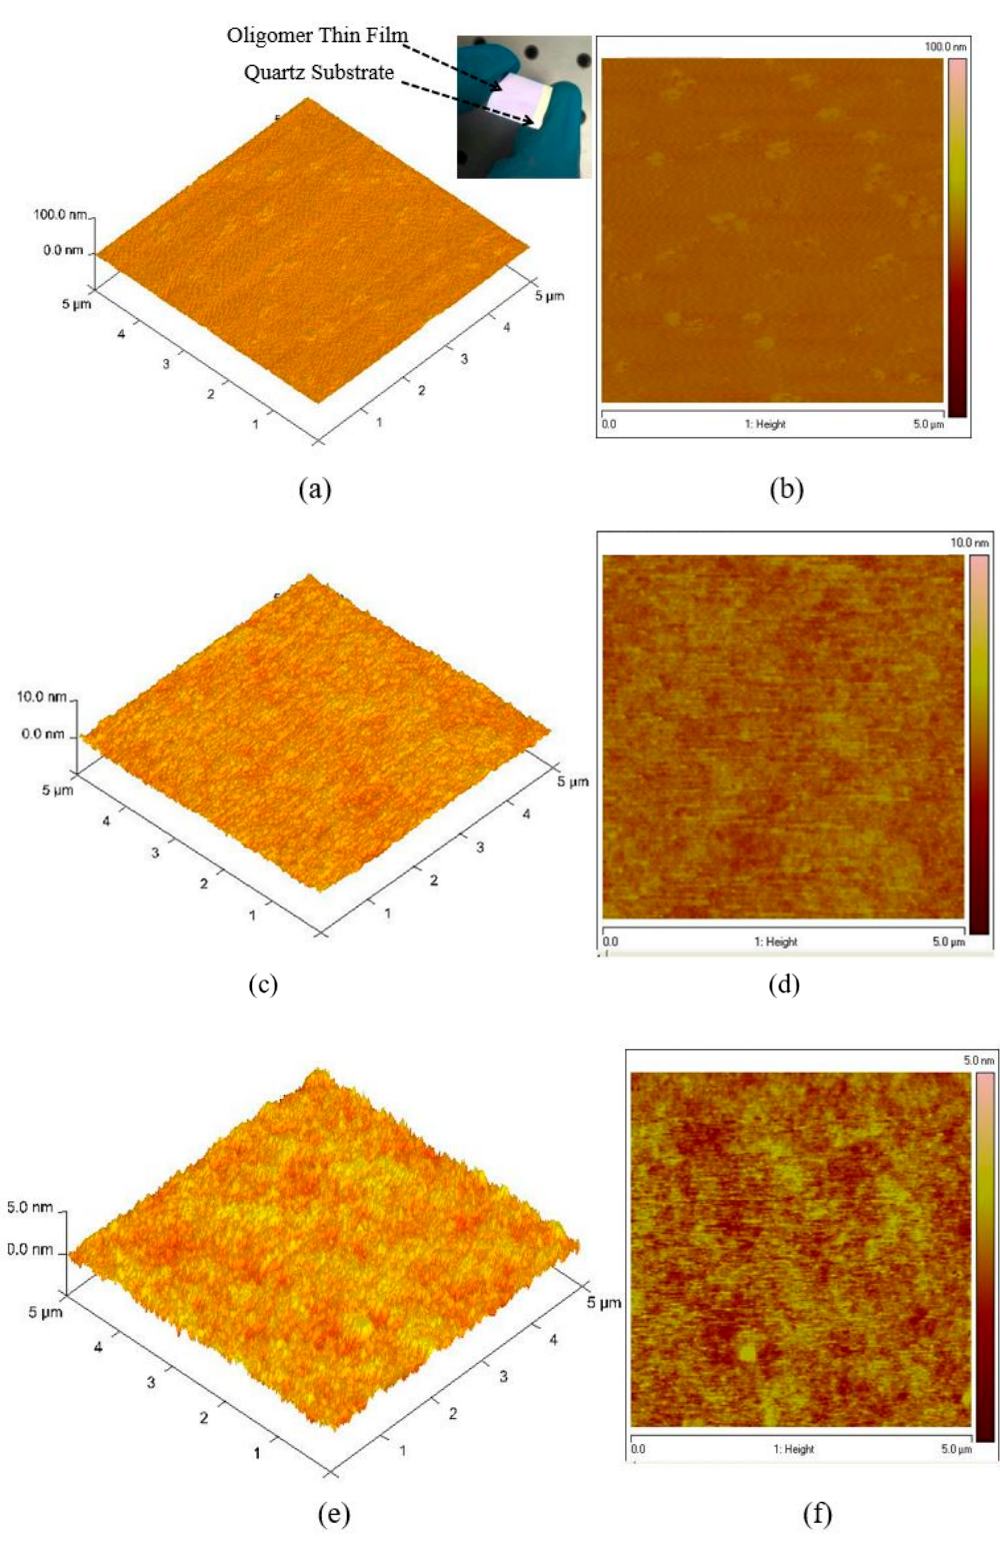
Figure 4. Atomic force microscopy (AFM) images of the oligomer at thicknesses of 270, 88, and 70 nm. ( a , c , e ) are 3D surface of film with thickness 270, 88 and 70 nm, similarly ( b , d , f ) are 2D morphology of film with thickness 270, 88 and 70 nm respectively.